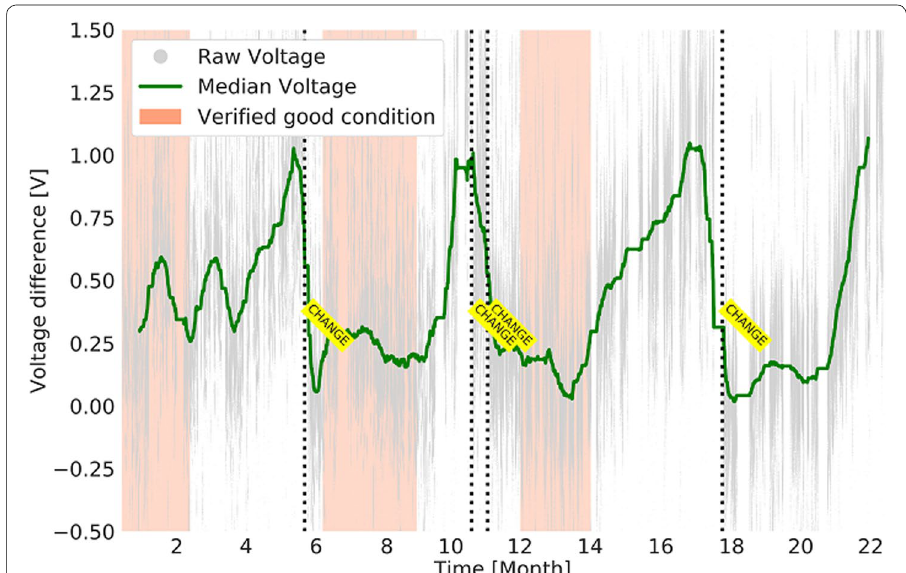
Fig. 6 Timeseries plot (complete data set) of the rectifier voltage difference (measured–theoretical) or “parasitic voltage” for an exemplary anode couple. The theoretical voltage for the plot is calculated from the physical model (Eqs. 1–2). The grey points are raw voltage differences (measured–theoretical), the green line is the median value of the raw difference data. The time window for calculating the median is approximately 10 days before and after (rolling median). The dashed vertical lines with the highlighted text present times of anode changes. The orange shaded areas represent the “good segments” used for machine learning model training and validation. The unshaded areas represent “bad segments”, while some low voltage difference areas were left out for our proof of concept